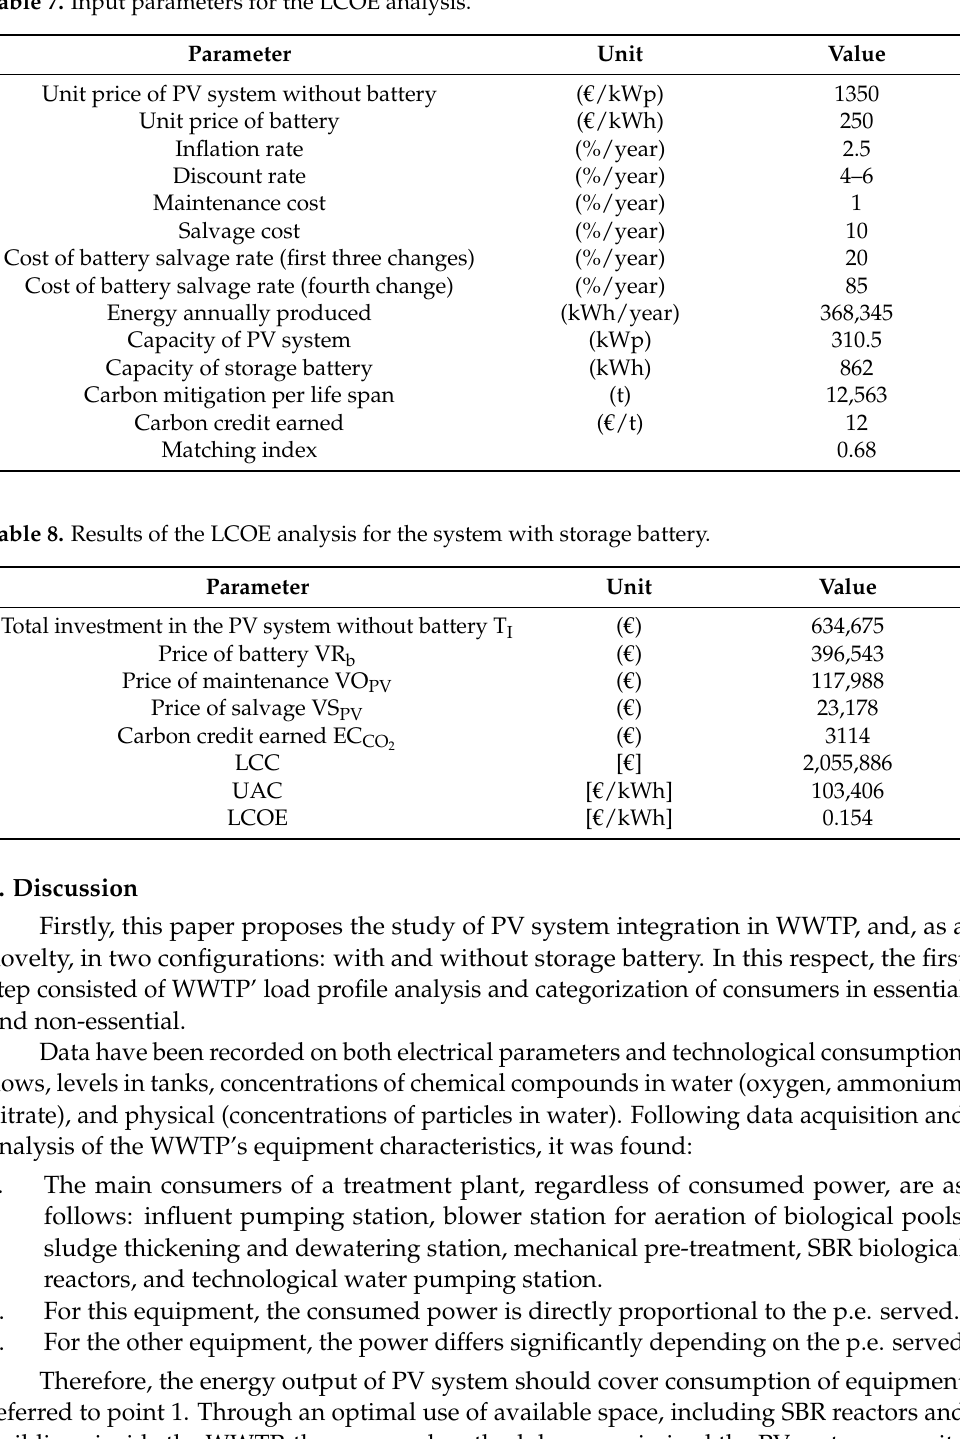
Table 7. Input parameters for the LCOE analysis.